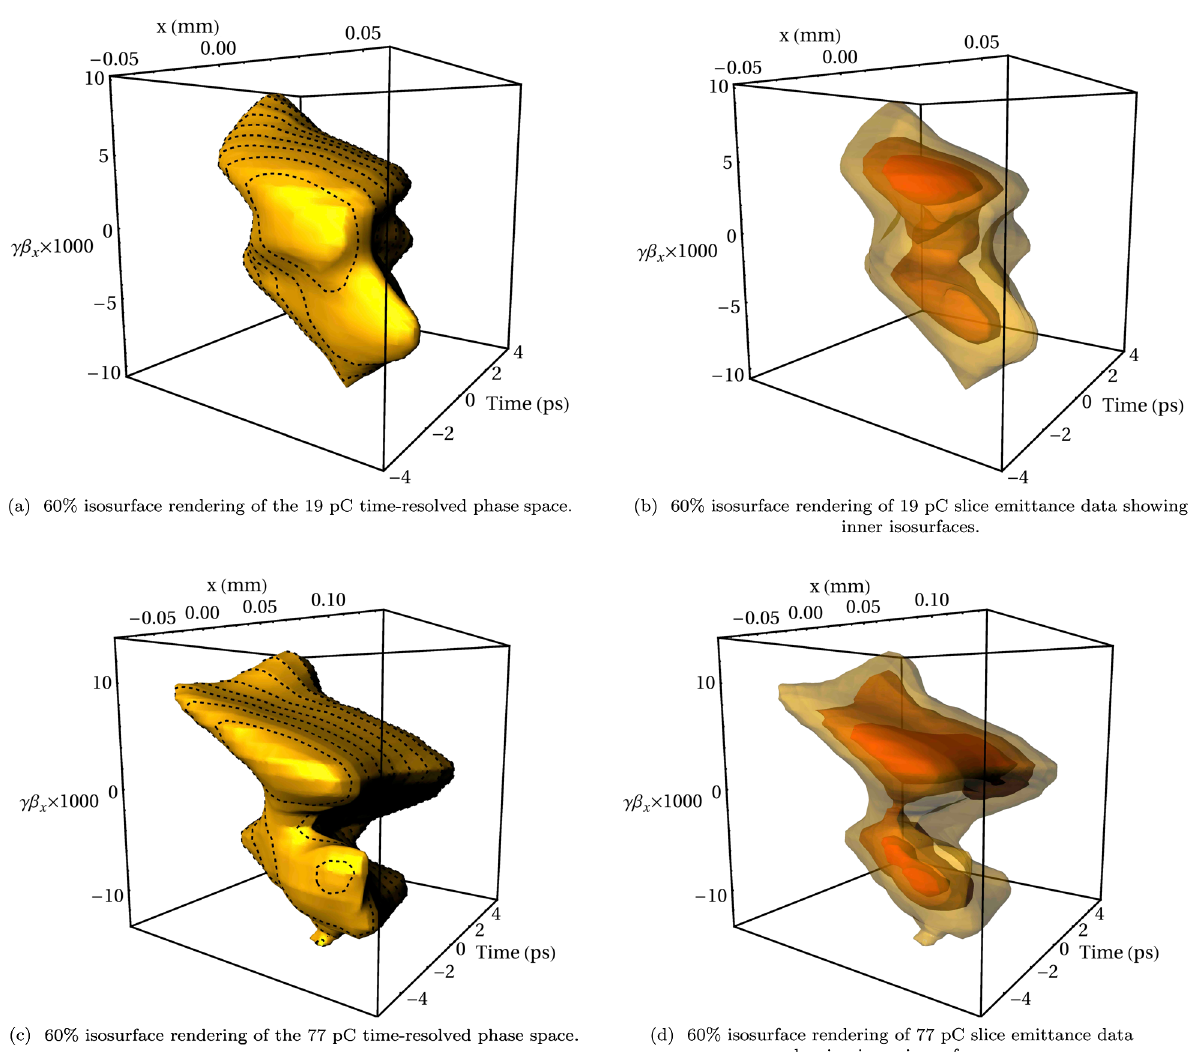
FIG. 18. Three-dimensional plotting of the time-resolved phase space.